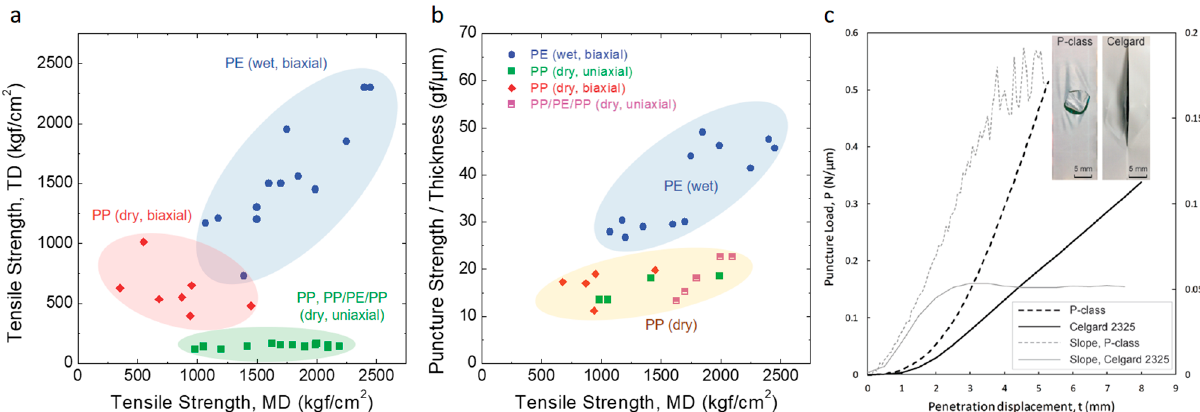
Figure 8. Correlations among mechanical properties of microporous polyolefin separators. ( a ) Tensile strength in the MD and TD [5,14,24,45,59–64]. ( b ) Puncture strength per thickness plotted against tensile strength in the MD [14,45,59–62]. ( c ) Examples of force–penetration displacement curves of P-class (UHMWPE separator) and Celgard 2325 (PP–PE–PP trilayer separator) for puncture resistance test. The inserts are the images of the samples after puncture fracturing. Reproduced with permission from [57].